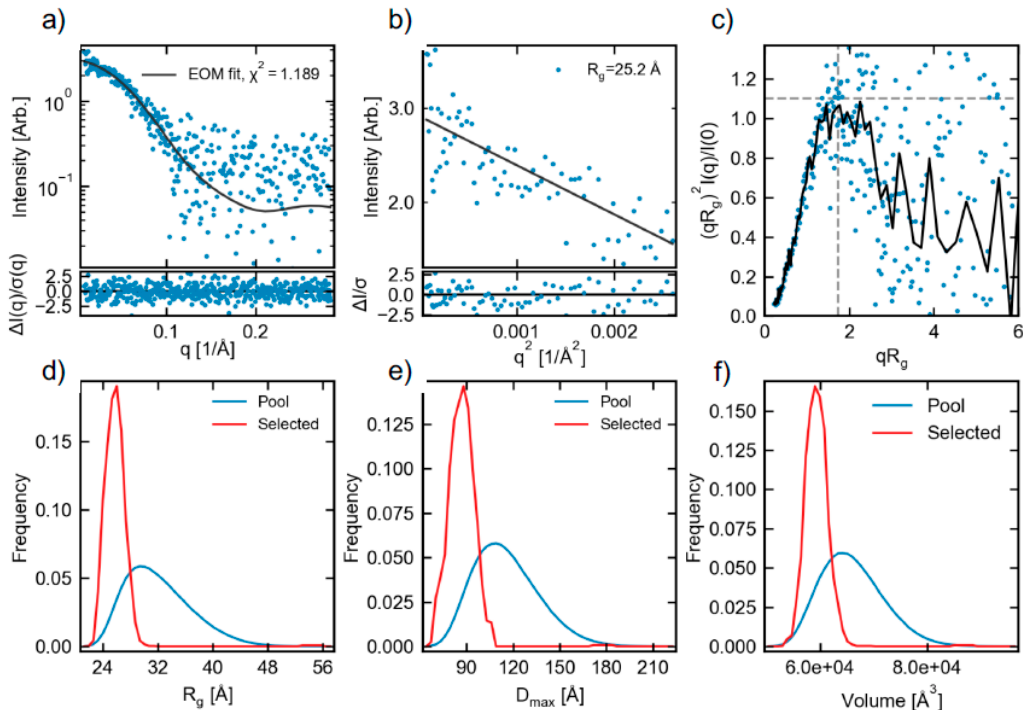
Figure 4. ( a ) SEC-SAXS scattering profile (blue points), EOM fit to the data (black line), and the normalized fit residual (bottom panel). ( b ) Guinier region for data (blue dots), Guinier fit (black line), and normalized fit residual (bottom panel). ( c ) Dimensionless Kratky plot. The dashed gray lines show where their peak for a compact globular protein would be. The black line is a log-rebinned version of the data, and fails to fall to 0 around qRg of ~5, which is what would be expected from a globular system. This suggests the measured system is flexible. ( d – f ) EOM results for the R g , D max , and volume, respectively, of the total pool (blue) and selected ensemble (red) of flexible structures in solution. In all three cases, the selected ensemble is much more compact than the possible pool of structures, which shows that the PG domain does not adopt all possible states in solution, but rather, is constrained to states mostly near the CA IX domain.